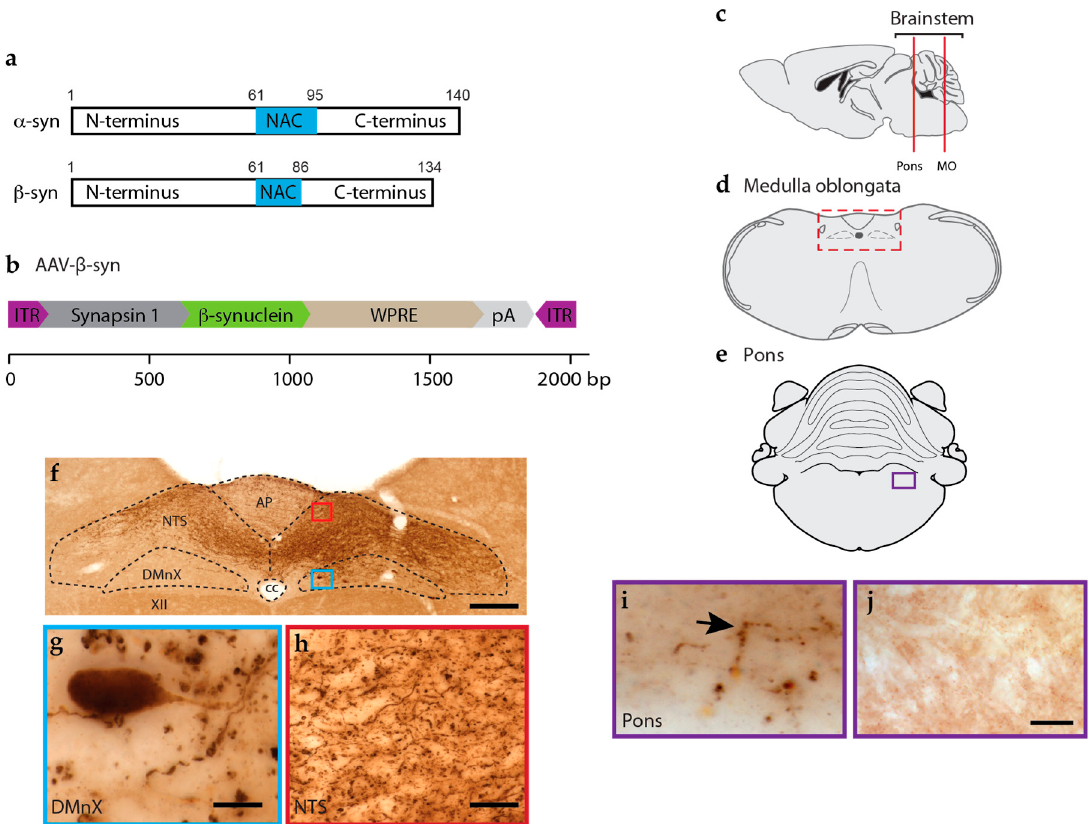
Figure 1. AAV- β -syn injections into the mouse vagus nerve induce increased expression of β -syn in the dMO and trigger its spreading to the pons. ( a ) Schematic illustration of α - and β -syn proteins displaying similarities in size and domain composition. ( b ) AAV- β -syn vector design illustrating the expression cassette flanking two ITRs. The scale displays the size (base pair, bp) of each genetic component. Mice received an injection of AAV- β -syn into the left vagus nerve. At 6 weeks post- surgery, coronal sections of the medulla oblongata and the pons were stained with a β -syn antibody. ( c ) Locations of the medulla oblongata and pontine coronal sections used for histological analyses are illustrated on a longitudinal plane. ( d ) Schematic image of a coronal section of the MO. The rectangular box (red) delineates an area of the dMO corresponding to the area shown in panel f. ( e ) Schematic image of a coronal section of the pons. The rectangular box (purple) delineates an area corresponding to the pontine area shown in panels i and j. ( f – h ) Representative image of the dMO showing β -syn immunoreactivity ( f ). Dotted lines in (f) delineate the borders between AP, NTS, DMnX, XII and cc. The blue and red boxes mark the locations of the areas shown at higher magnification in ( g , h ). These higher magnification images were acquired from the DMnX ( g ) and NTS ( h ) ipsilateral to the injection side. Scale bars: 200 µ m ( f ) and 20 µ m ( g , h ). ( i ) β -syn immunore- activity in a representative pontine section displaying β -syn-filled axons (arrow). Scale bar: 10 µ m. ( j ) β -syn immunoreactivity in a pontine section collected from an untreated naïve mouse. Scale bar: 10 µ m. Abbreviations: XII: nucleus of the hypoglossal nerve; AP: area postrema; cc: central canal; dMO: dorsal medulla oblongata; DMnX: dorsal motor nucleus of the vagus nerve; ITR: inverted terminal repeat; NAC: non-amyloid component; NTS: nucleus tractus solitarius; pA: polyA; WPRE: woodchuck hepatitis virus posttranscriptional regulatory